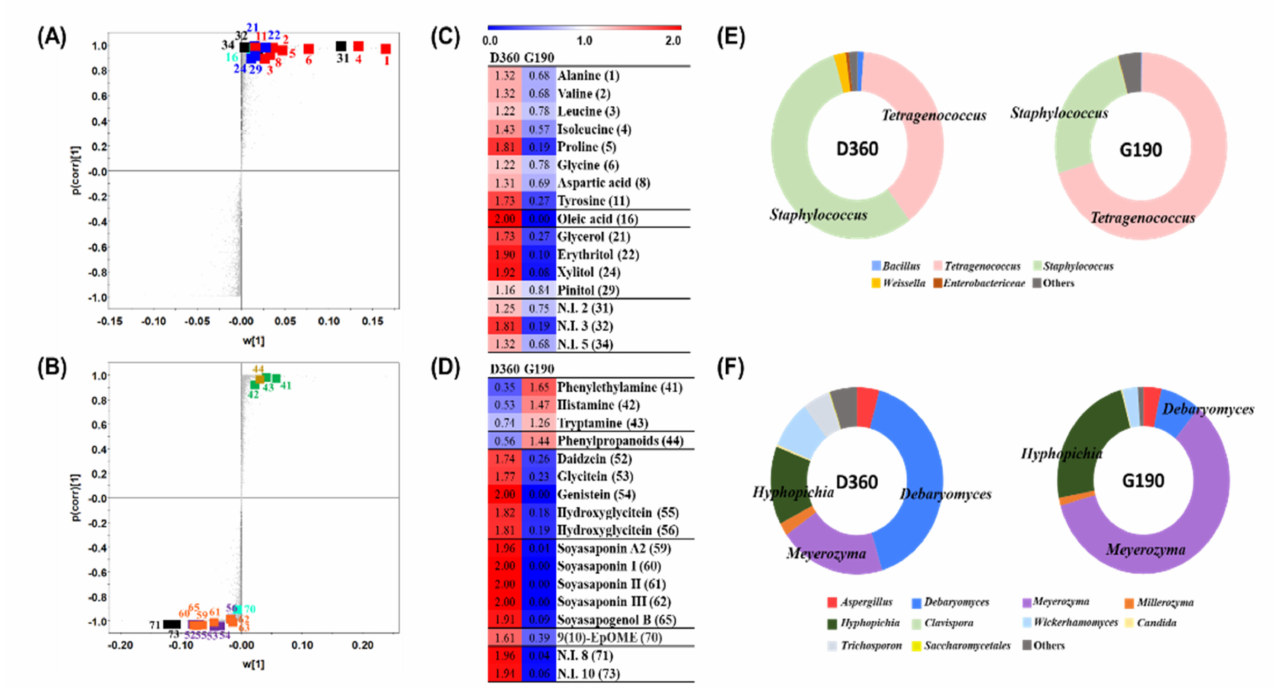
Figure 6. OPLS-DA S-plots derived from non-targeted metabolite profiling of doenjang and ganjang end products analyzed using GC-TOF-MS ( A ) and UHPLC-Orbitrap-MS/MS ( B ) (VIP > 1.5, p < 0.05). Metabolite compounds: amino acids ( (cid:4) ), fatty acids ( (cid:4) ), sugar and sugar derivatives ( (cid:4) ), isoflavonoids ( (cid:4) ), soyasaponins ( (cid:4) ), biogenic amine ( (cid:4) ), phenylpropanoids ( (cid:4) ), and not identified ( (cid:4) ). Heat map derived from GC-TOF-MS ( C ) and UHPLC-Orbitrap-MS/MS ( D ). The values represent fold changes by an average peak area of each metabolite. Relative abundances of bacteria ( E ) and fungi ( F ) present in meju , doenjang 360 d, and ganjang 190 d at the genus levels. “Others” comprise bacterial and fungal groups with <5% relative abundance in all